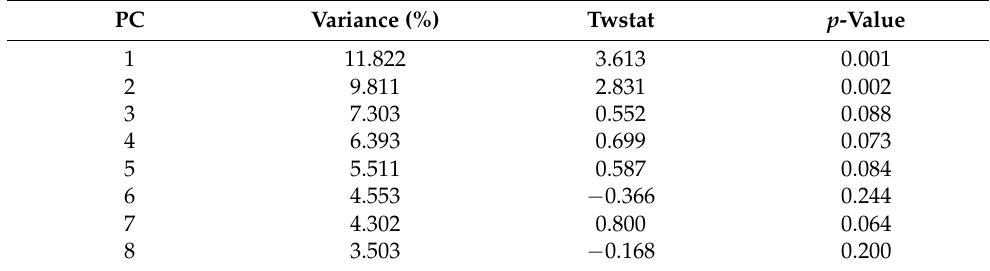
Table 2. Statistical information for the first eight principal components of population variation.